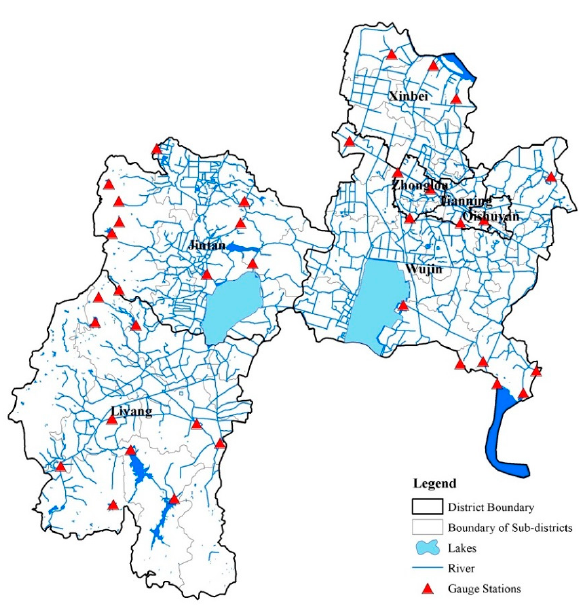
Figure 4. Distribution of gauge stations. Table 1. Comparison between detection results and real damage conditions.